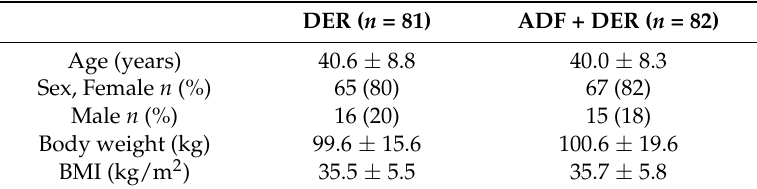
Table 2. Baseline participant characteristics 1 .